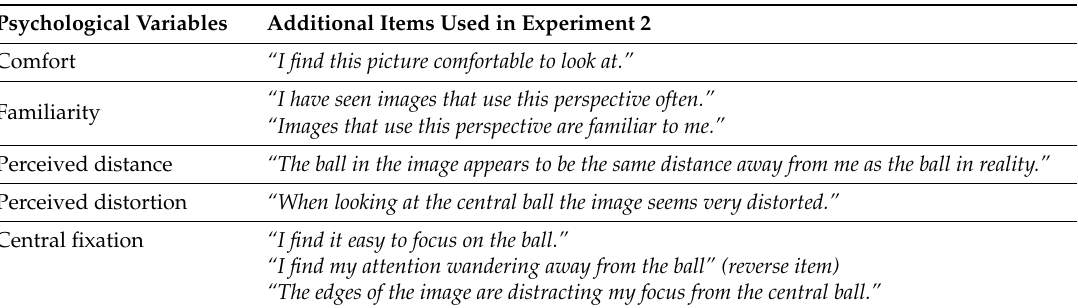
Table 3. The table lists all the additional items used in the extended version of the questionnaire in Experiment